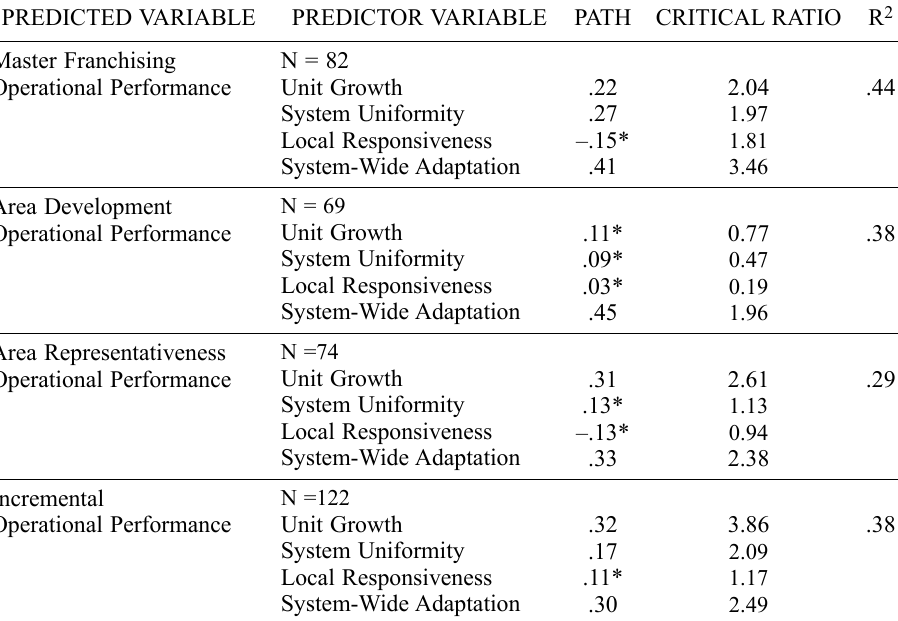
Table 4. PLS results for the structural